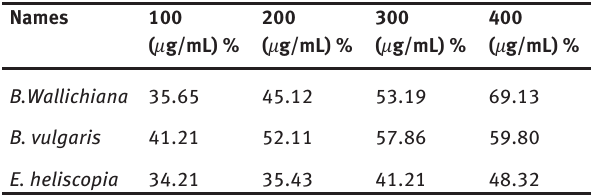
Table 7: Antioxidant activities of the plant species studied using alcoholic plant